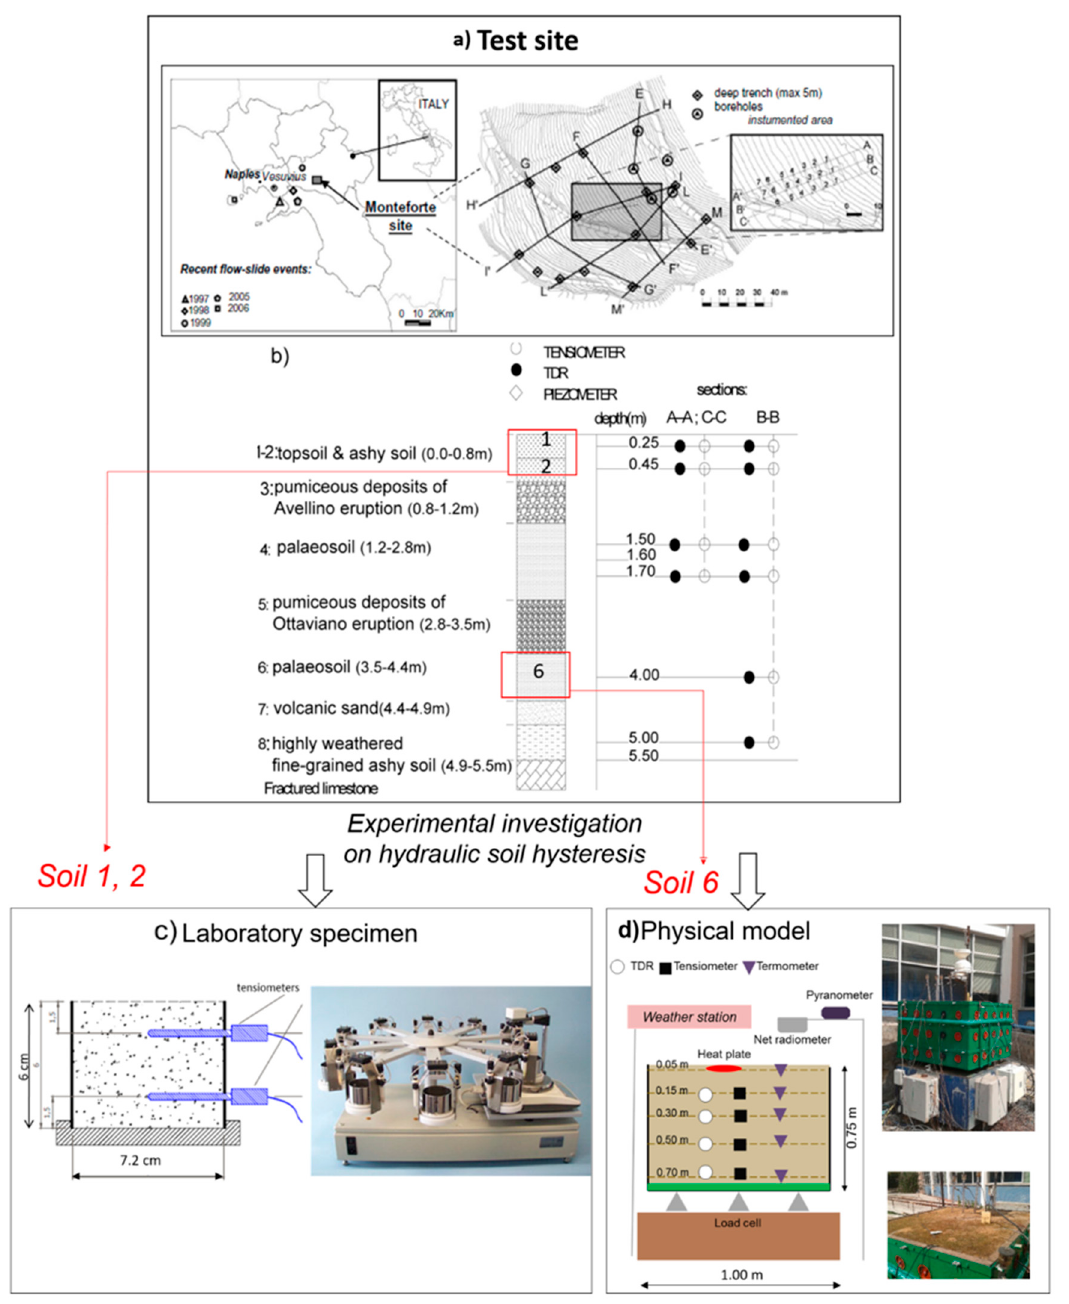
Figure 1. ( a ) The test site of Monteforte Irpino (Southern Italy); map with indications of trenches and boreholes; and ( b ) simplified stratigraphic soil profile with the layout of the instrumentation installed along each monitored vertical section along section B–B’. Methods adopted to test the hydraulic soil properties: ( c ) evaporation and imbibition tests on soil specimens (investigation at a small scale); and ( d ) monitoring of the physical prototype (investigation at a medium